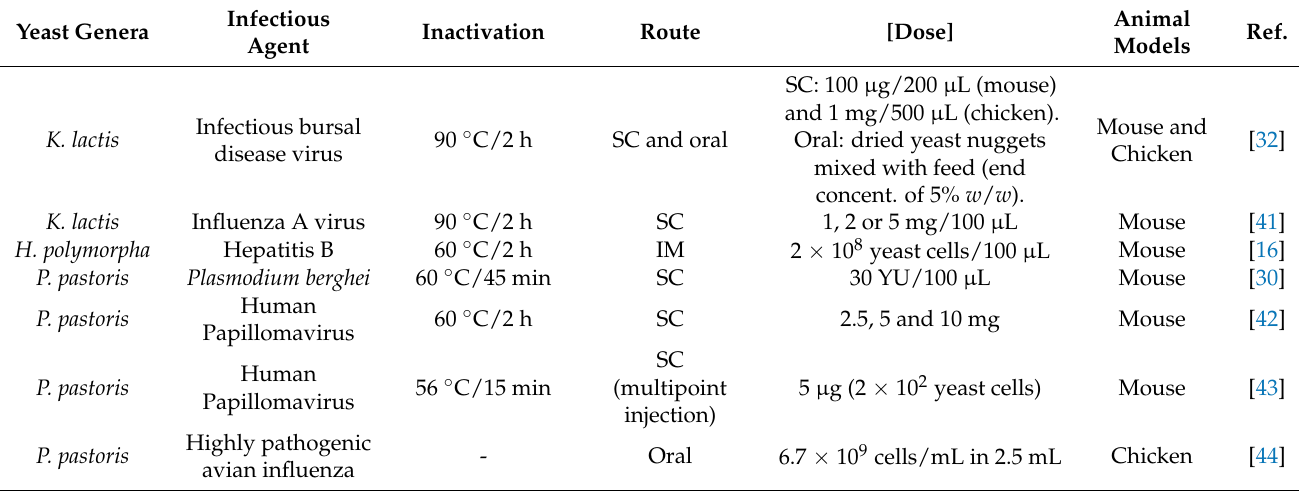
Table 1. Preclinical studies with whole yeast cells employing different yeast genera, routes, and animal